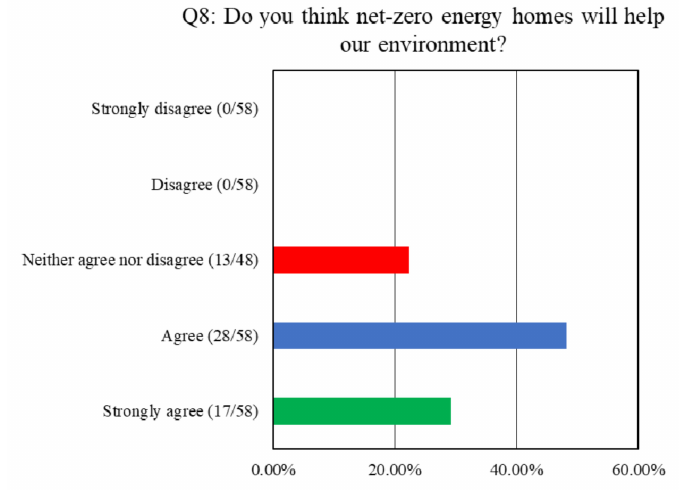
Figure 9. Participants’ agreeance or disagreeance on environment-friendliness of NZE homes.